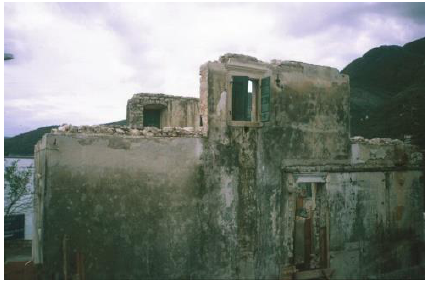
Figure 28. Captain’s house dating from 1842, before and at the beginning of reconstruction.